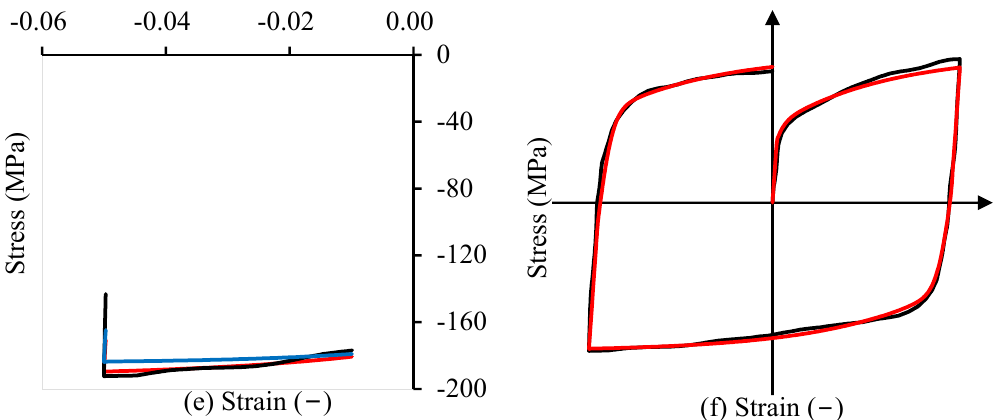
Figure 9. Intervals and stress-strain curves with VW-PSO: ( a , b ) Interval I and corresponding stress-strain curve; ( c , d ) Interval II and corresponding stress-strain curve; ( e , f ) Interval III and corresponding stress-strain curve.